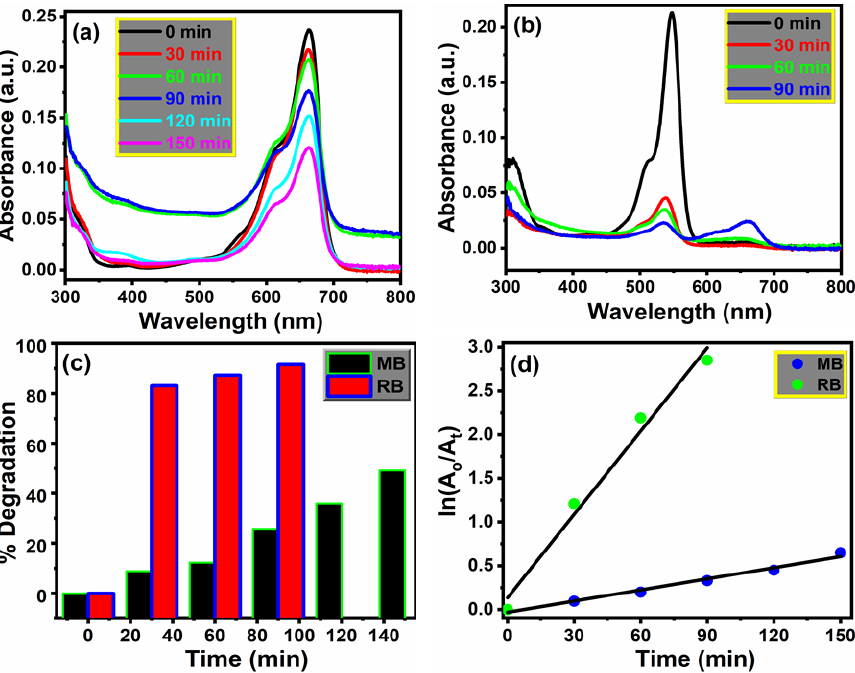
Figure 7. Absorption spectra of dyes at various time intervals under visible-light irradiation: ( a ) methylene blue, and ( b ) rose bengal dye. ( c ) Photocatalytic degradation of dyes and ( d ) kinetic relationship of ln ( A o / A t ) vs. irradiation time. Table 2. Kinetic parameters for Ni-CoWO 4 toward dyes MB and RB.